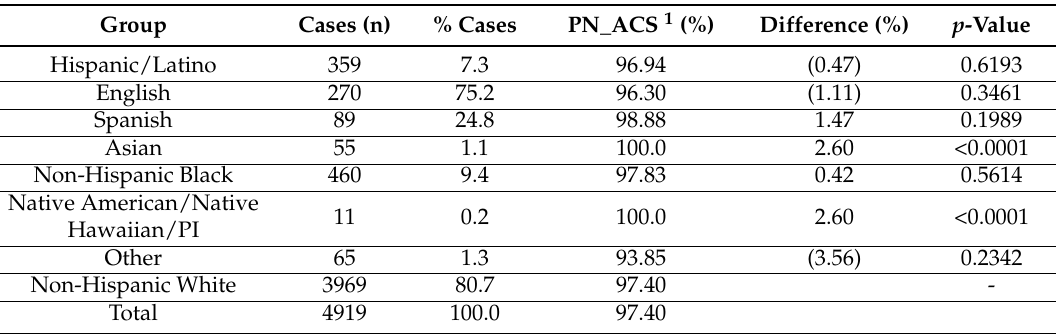
Table 3. Baseline Data Pneumonia (PN).